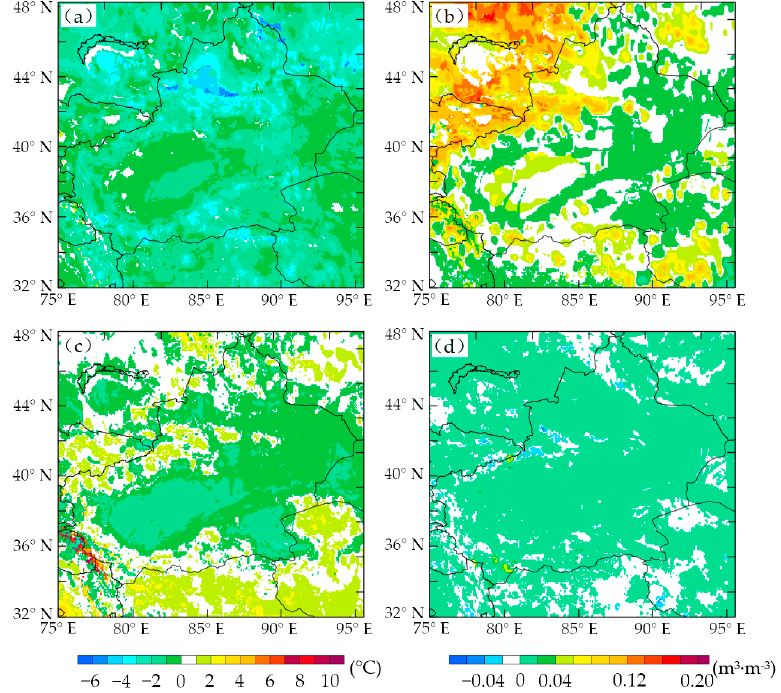
Figure 4. Monthly mean differences of simulated surface soil temperature ( a , c ) and soil moisture ( b , d ) in January ( a , b ) and July ( c , d ) 2017 between Noah and Noah-MP scheme.